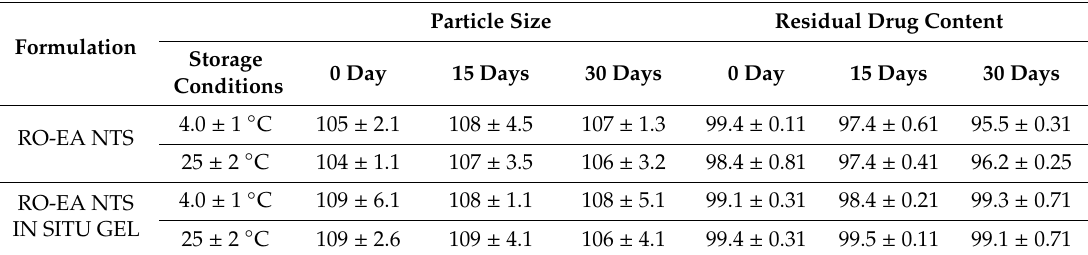
Table 8. Results of stability studies for RO-EA NTS and RO- EA NTS in situ gel at di ff erent storage